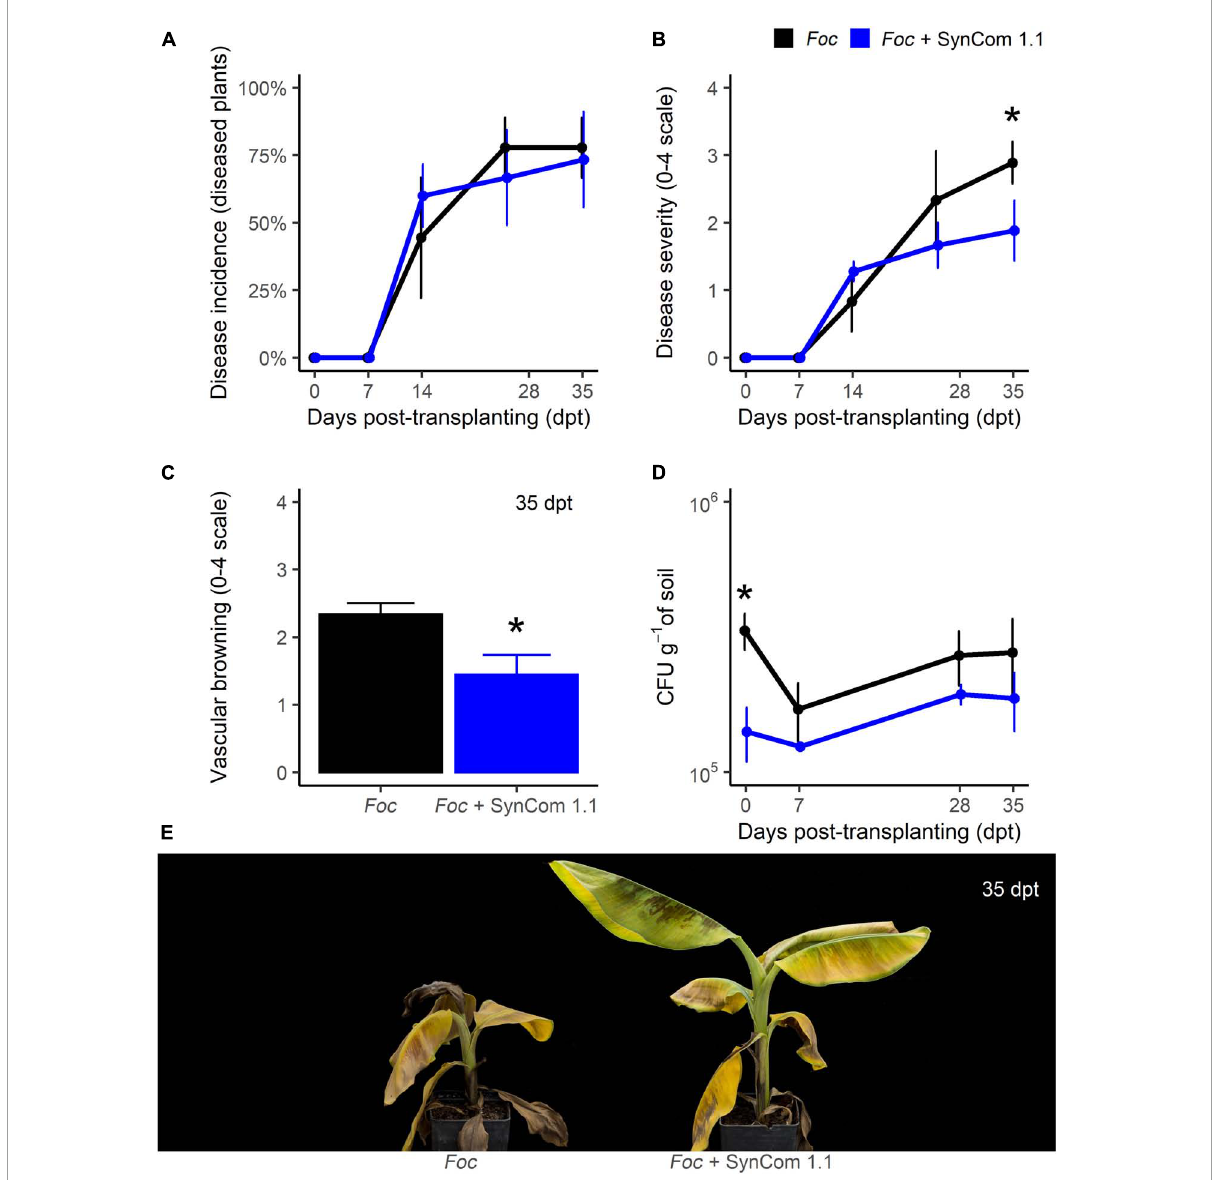
FIGURE4 Biocontrol trial B: SynCom 1.1. Banana plants ‘Gran Enana’ were grown in steam-sterilized soil inoculated with 5.10 5 CFU g − 1 soil of Fusarium oxysporum f. sp. cubense ( Foc ) tropical race 4, alone or in combination with the synthetic microbial community SynCom 1.1. Fusarium wilt incidence (A) , symptom severity (B) , vascular browning (C) , and Fusarium spp. soil population (D) were measured to assess the biocontrol effectiveness of SynCom 1.0. Symptoms occurring on treated and control plants are shown in (E) . Bars indicate standard error ( n = 3 in A,D , while n = 15 in B,C ). Asterisks indicate significant differences between treated and control plants according to the Dunn’s test or the t -test ( P < 0.05) in (A–C,D) ,